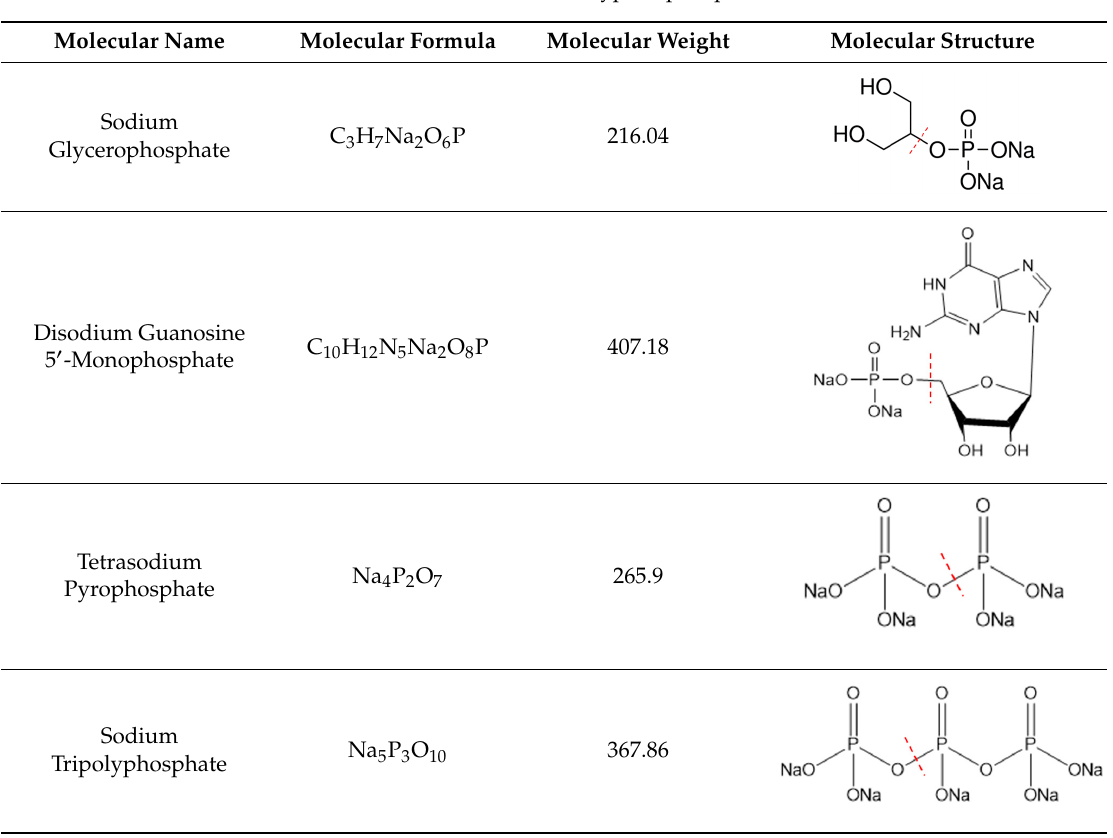
Table 1. Details of the four typical Table 1. Details of the four typical phosphates. Table 1. Details of the four typical phosphates. Table 1. Details of the four typical phosphates. Table 1. Details of the four typical phosphates.